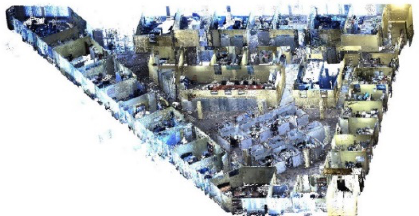
Figure 7. The overall test site, ceiling is removed from the point cloud for the bird-eye view.